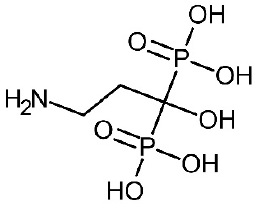
Figure 2. Chemical structure of pamidronic acid.